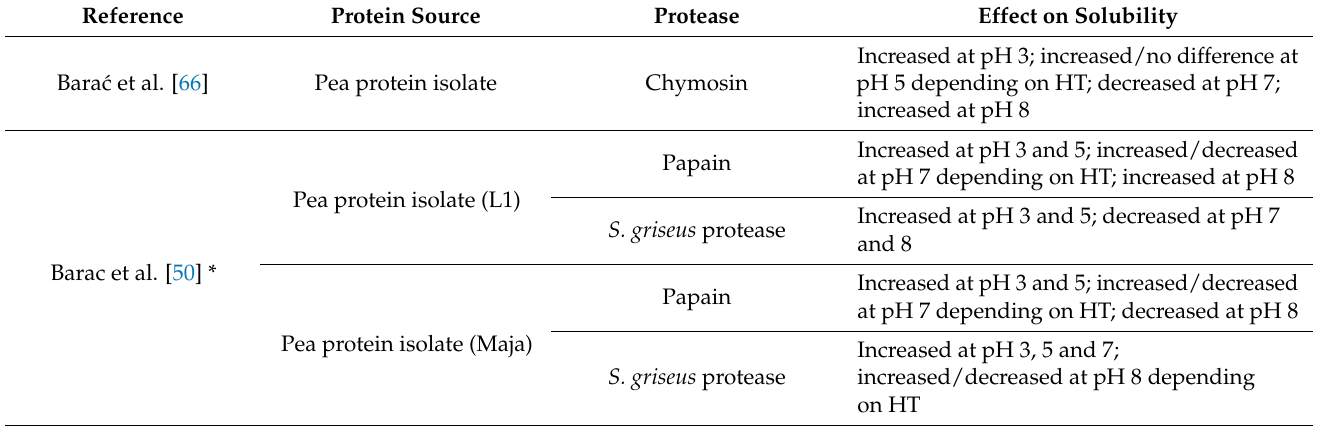
Table 2. Overview of the effects of enzymatic hydrolysis on solubility, with various pulse protein sources and